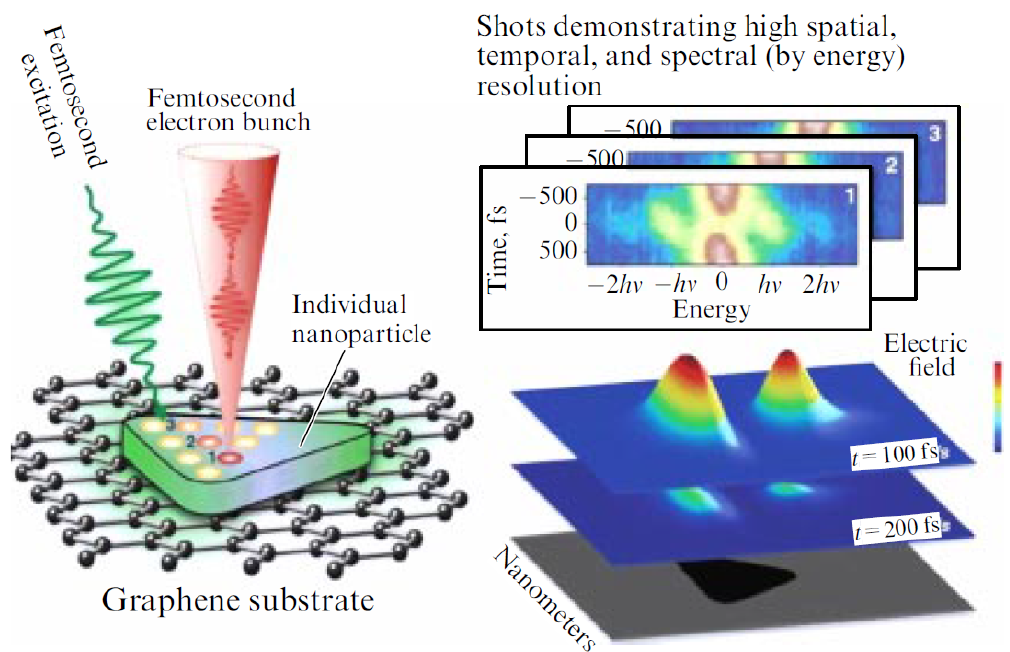
Figure 4. Subparticle ultrafast spectrum imaging in UEM. The change in the electron kinetic energy (electron spectrum) was measured as a function of the delay between an exciting femtosecond laser and probing electron pulses for each position of the probe. Energy gain was measured in units of laser radiation quantum, h ν = 2.4 eV [45]. Figure was adapted from work in [45] with permission from Science AAAS.